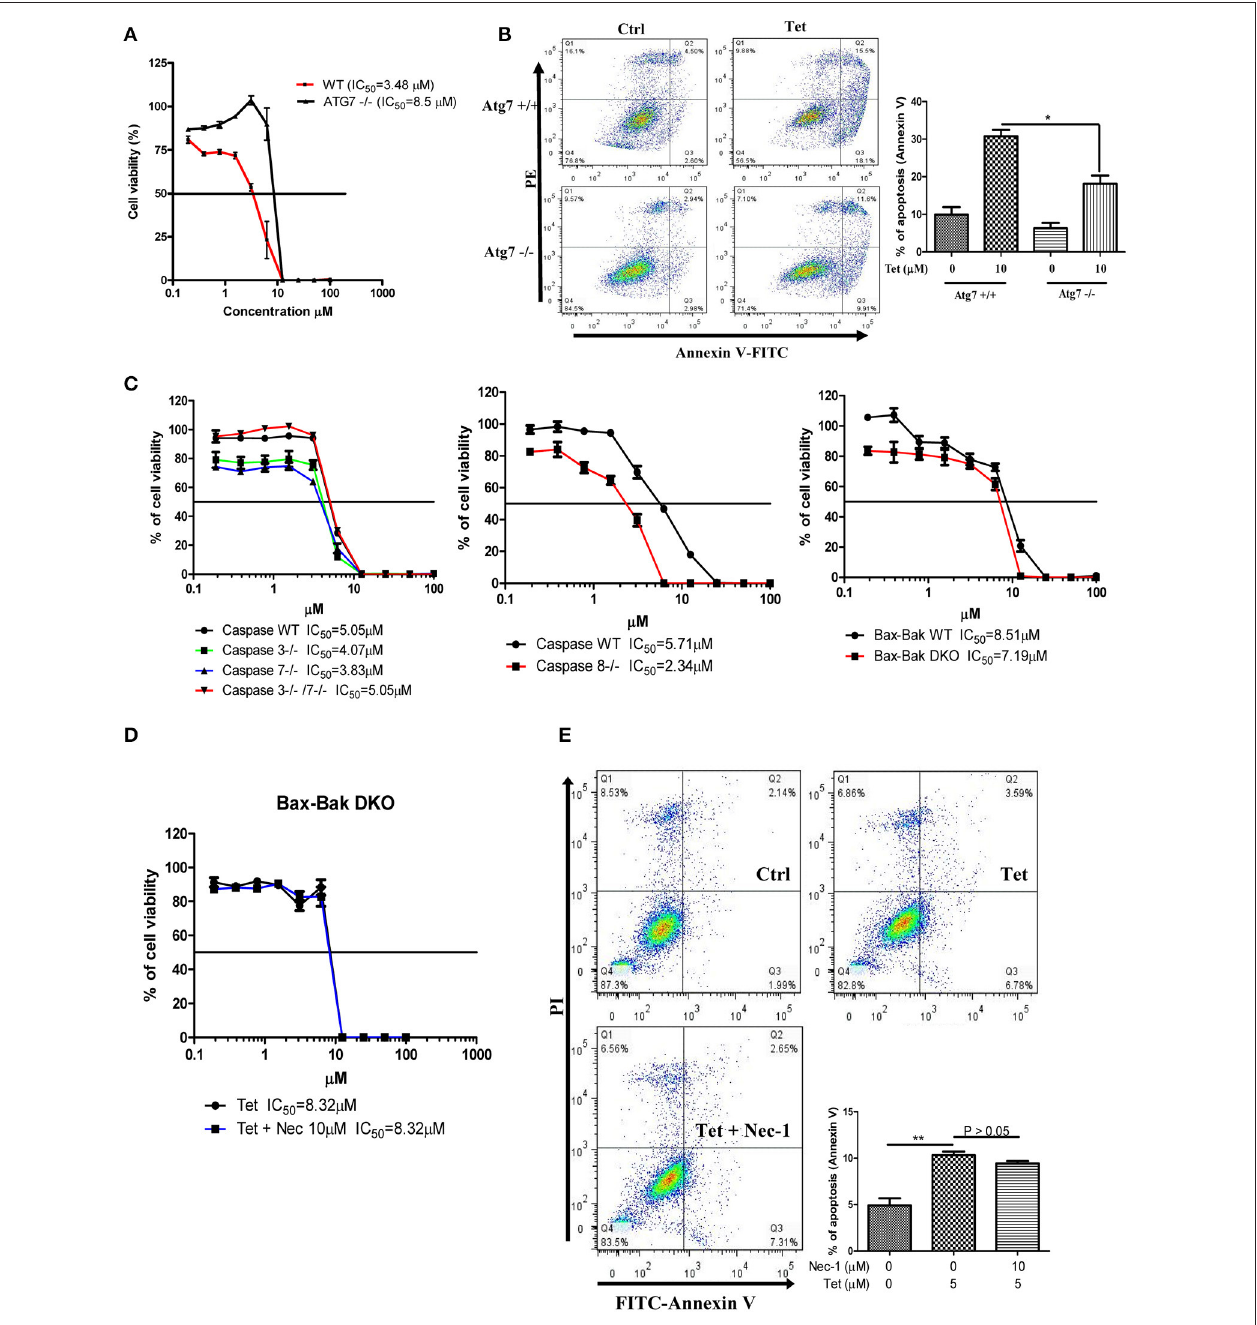
FIGURE 5 | Tetrandrine induces autophagic cell death in apoptosis resistant cells. (A) Cytotoxicity of Tet on ATG7 wild-type and ATG7 − / − MEFs as measured by MTT assay, and (B) flow analysis after annexin V staining. (C) Cytotoxicity (IC 50 ) of Tet on caspase 3/7 or caspase 3 and 7 knockout cells (left panel), caspase 8 knockout cells (middle panel), and Bax-Bak wild-type and DKO deficient MEFs cells (right panel). (D) Tet-mediated cell cytotoxicity (IC 50 ) in Bax-Bak DKO MEFs with the presence of 10 µ M necrostatin (Nec-1) for 24 h as measured by MTT assay, and (E) flow cytometry analysis after annexin V staining. Results shown are the means ± S.E.M. of three independent experiments. ** p < 0.01; * p <